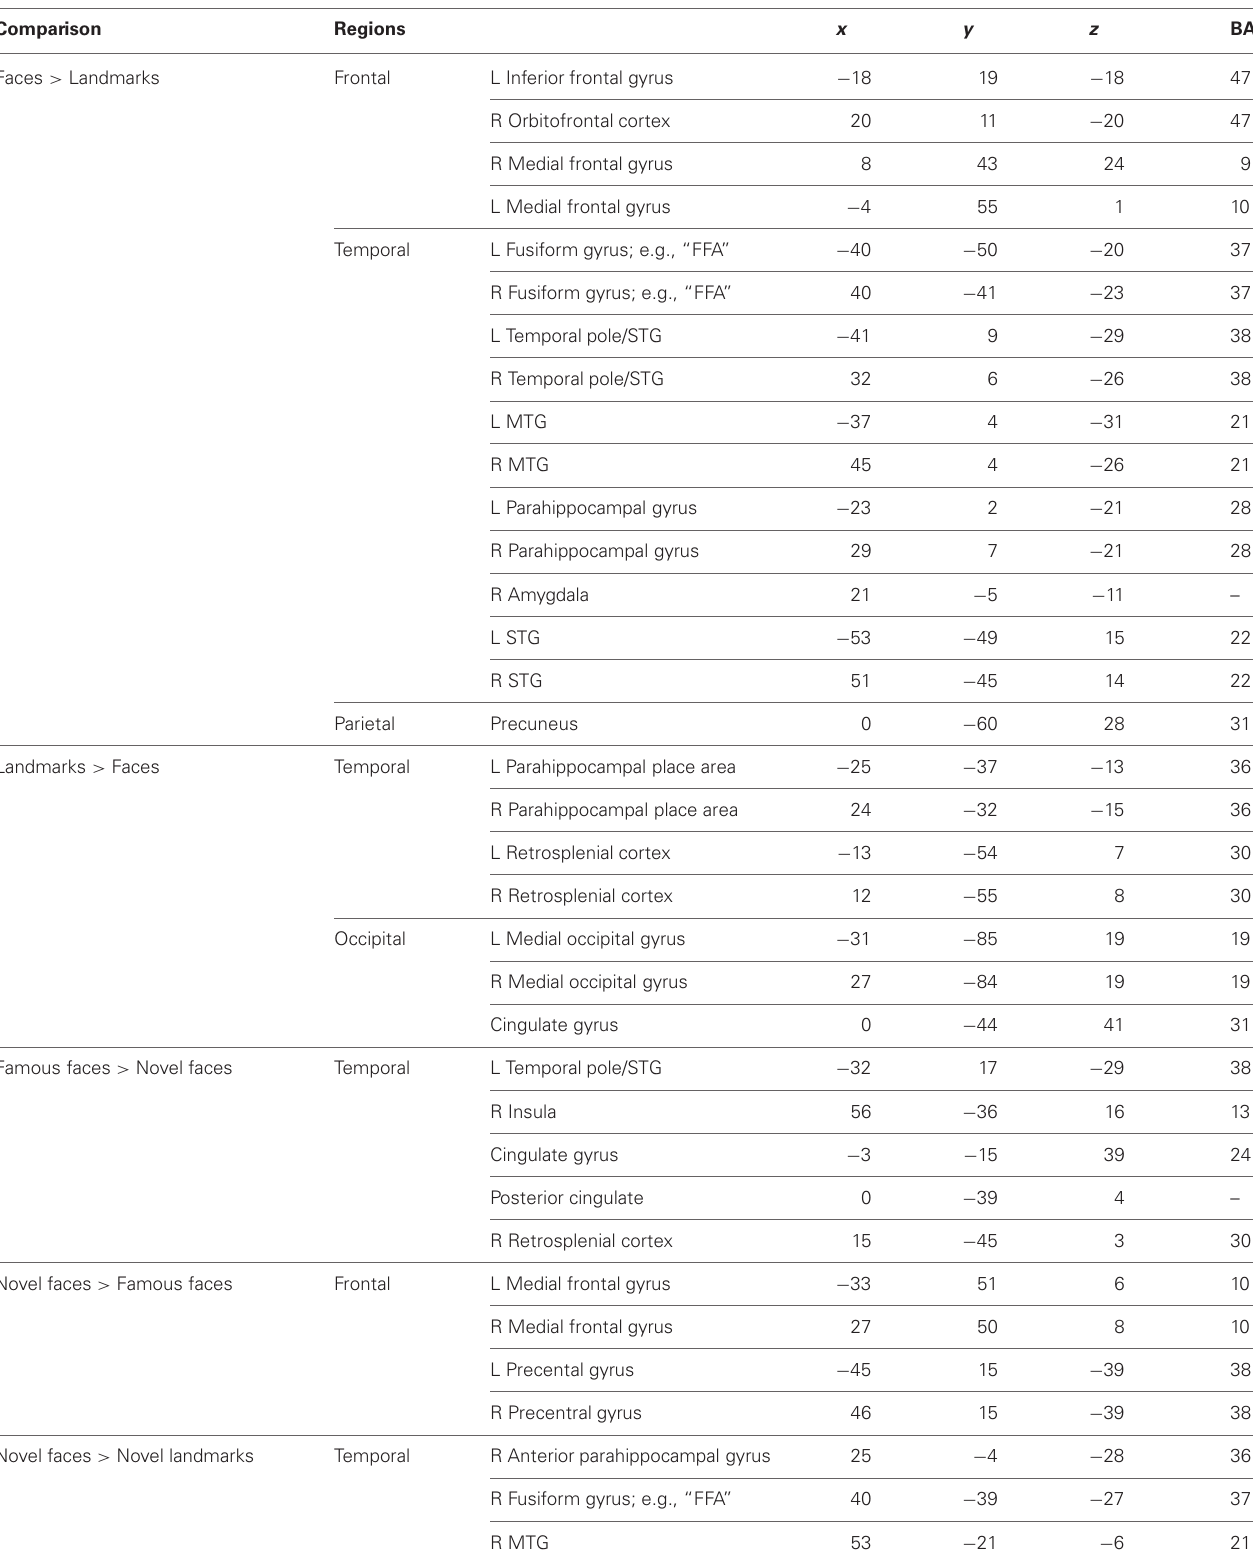
Table 3 | Talairach coordinates of peak activations from the empirical